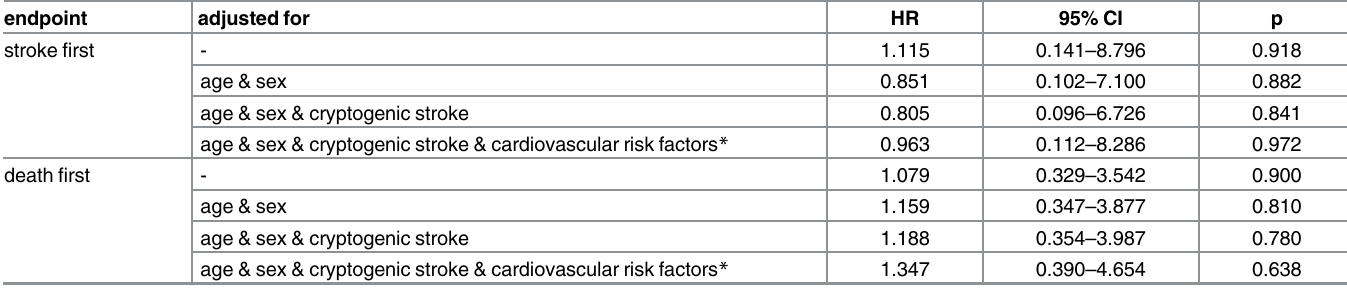
Table 7. Multivariate analysis for atrial fibrillation